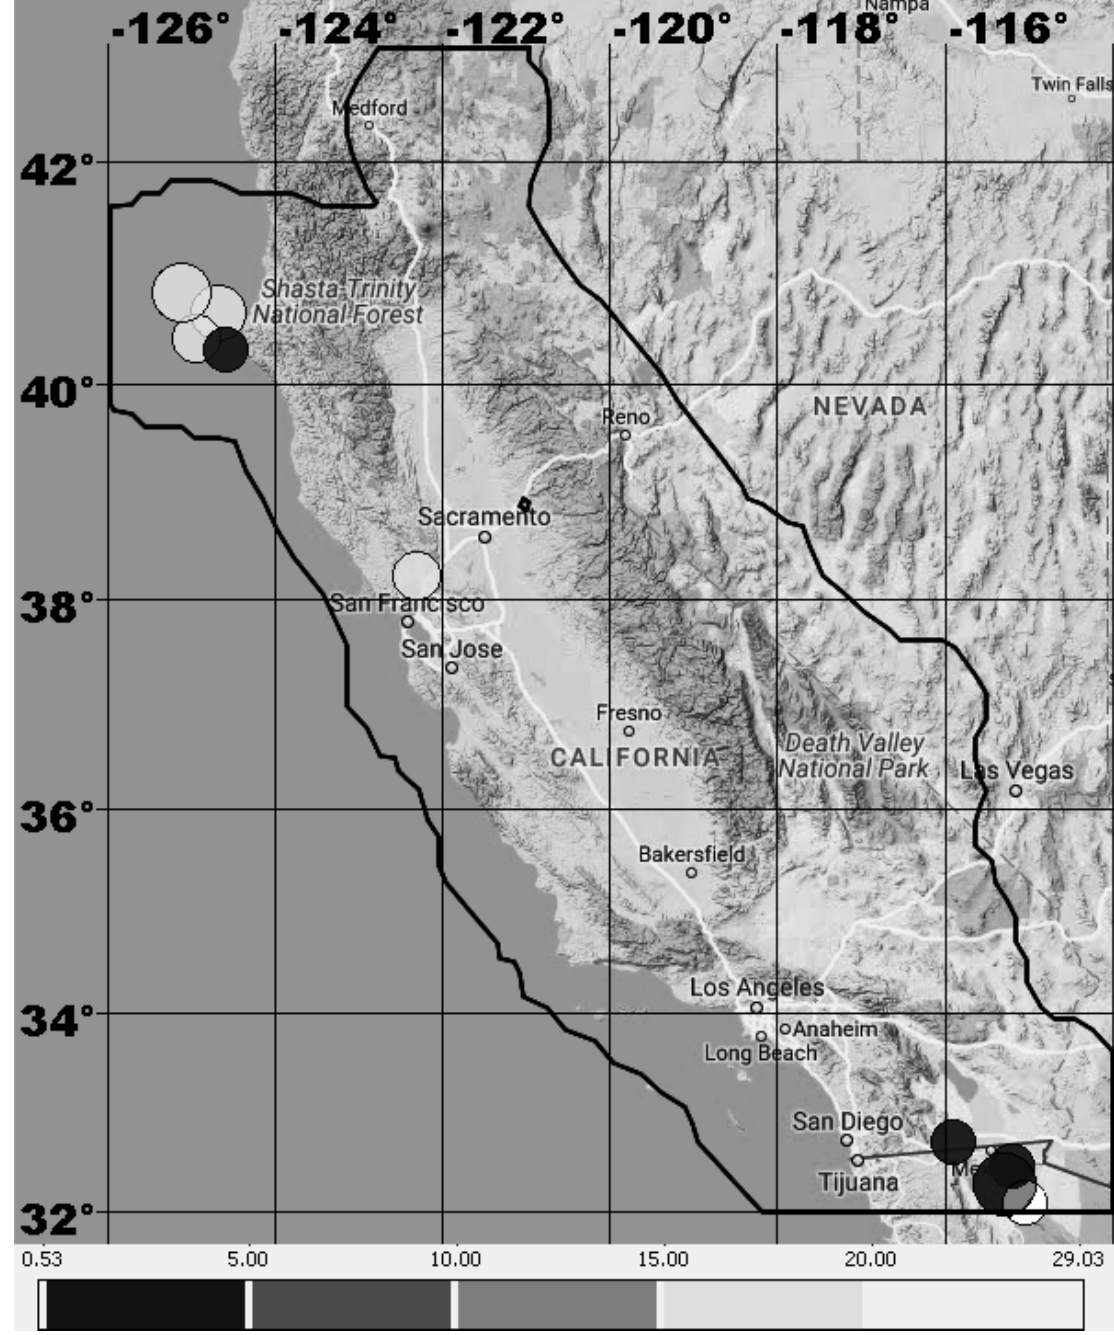
Figure 4. Area of analysis (marked with thick black line) and tested target epicenters of earthquakes in 2009–2018 in California. Shades of grey indicates the minimum volume of alarm with which the epicenter was forecasted. Darkness of grey decreases in accordance with the volume of the alarm: 0.05, 0.1, 0.15, 0.2. A white color indicates that an earthquake is not forecasted with an alarm volume of less than